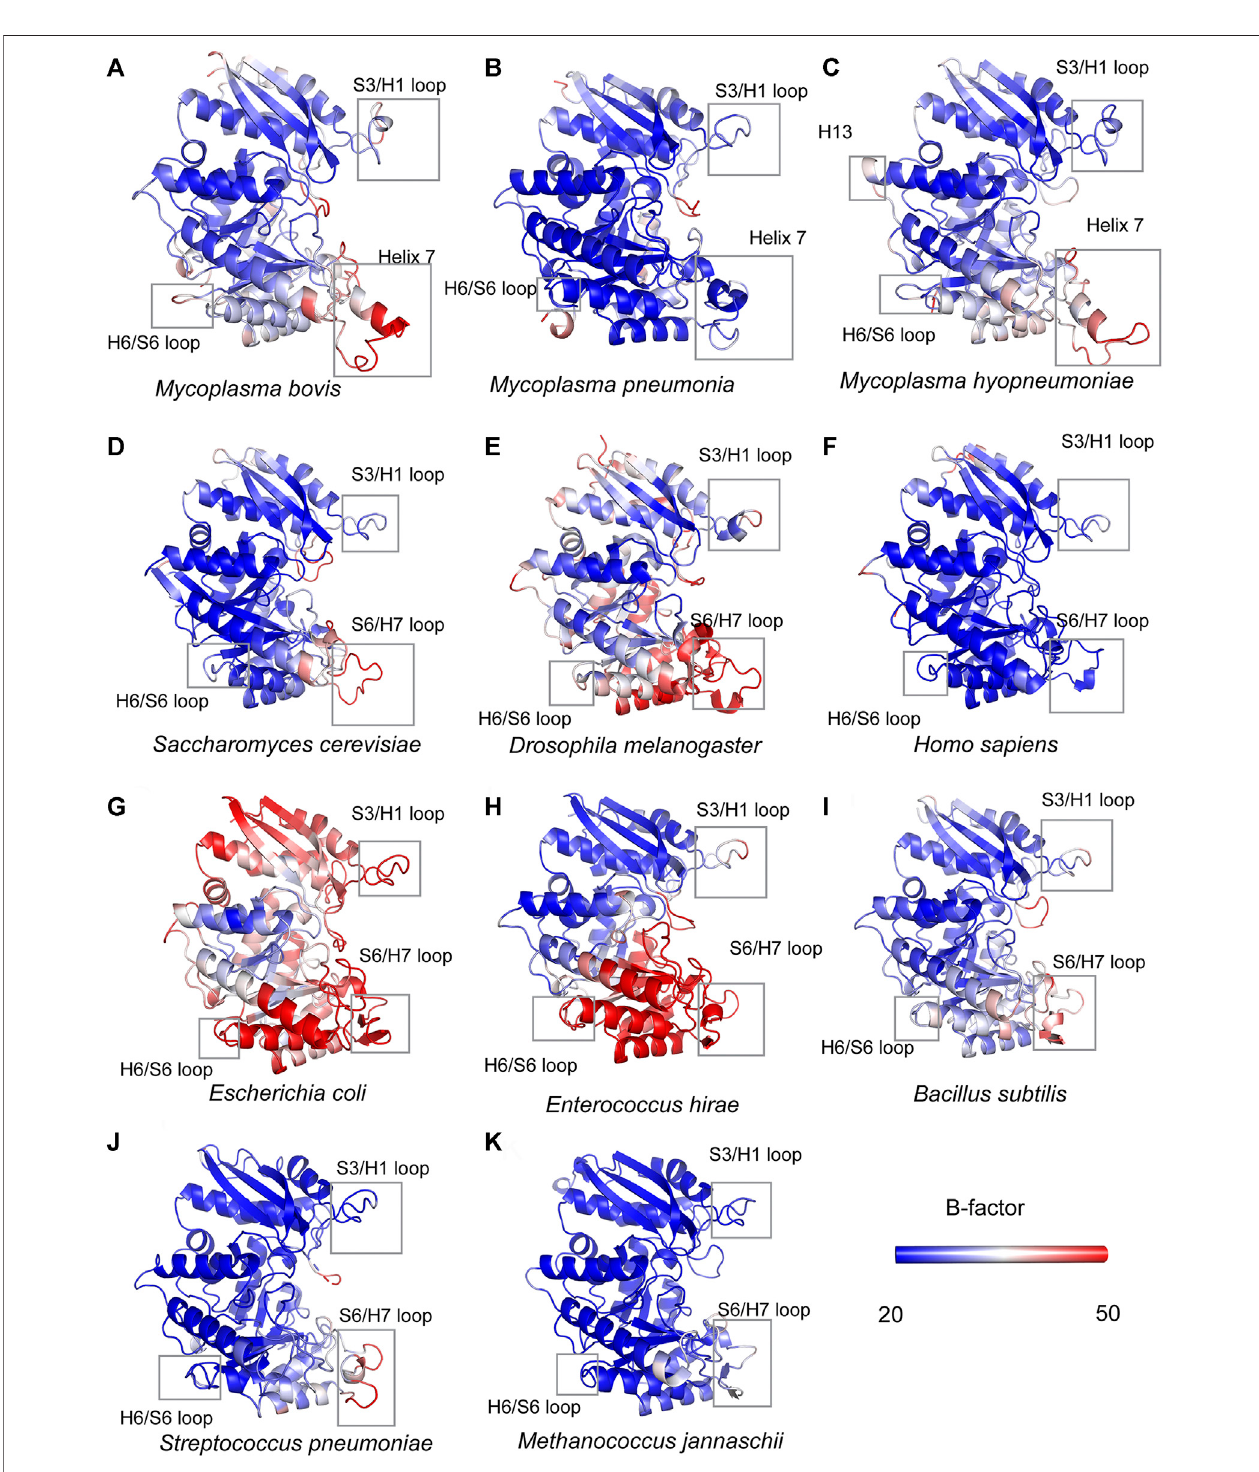
FIGURE 5 | Structural comparisons of mycoplasma enolases and other enolases. All the enolases are shown in cartoon mode and in the color of blue-white-red spectrum according to crystallographic B factors. The color bars show the B-factor scales for the corresponding forms. Species names are below corresponding enolase structure modes. Helix 7, H13, H6/S6 loop, S6/H7 loop regions are marked by rectangles. The accession numbers for enolases are the same as used in Supplementary Table S2 .